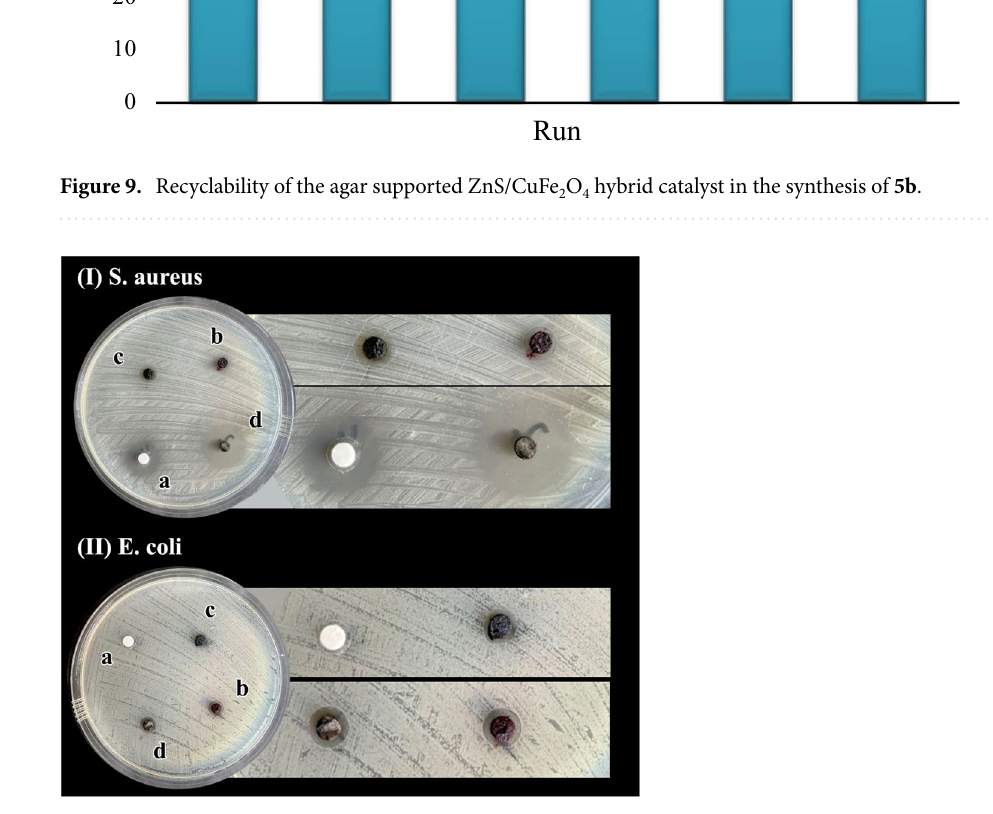
Figure 10. Inhibition zone of ( a ) ZnS, ( b ) CuFe 2 O 4 , ( c ) ZnS/CuFe 2 O 4 , and ( d ) the agar supported ZnS/CuFe 2 O 4 against E.coli and S. aureus cultures.